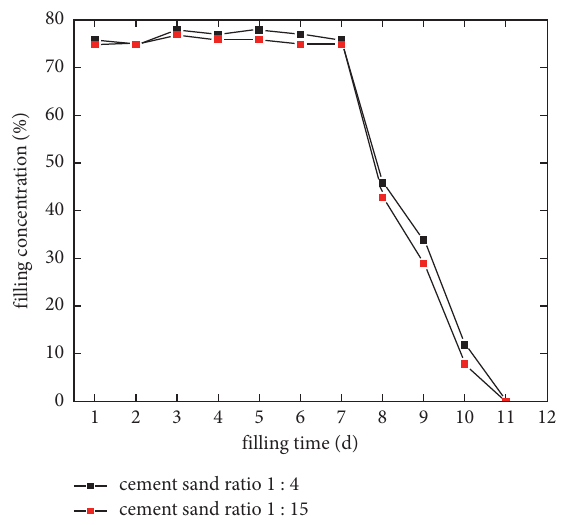
Figure 10: Variation of filling concentration.